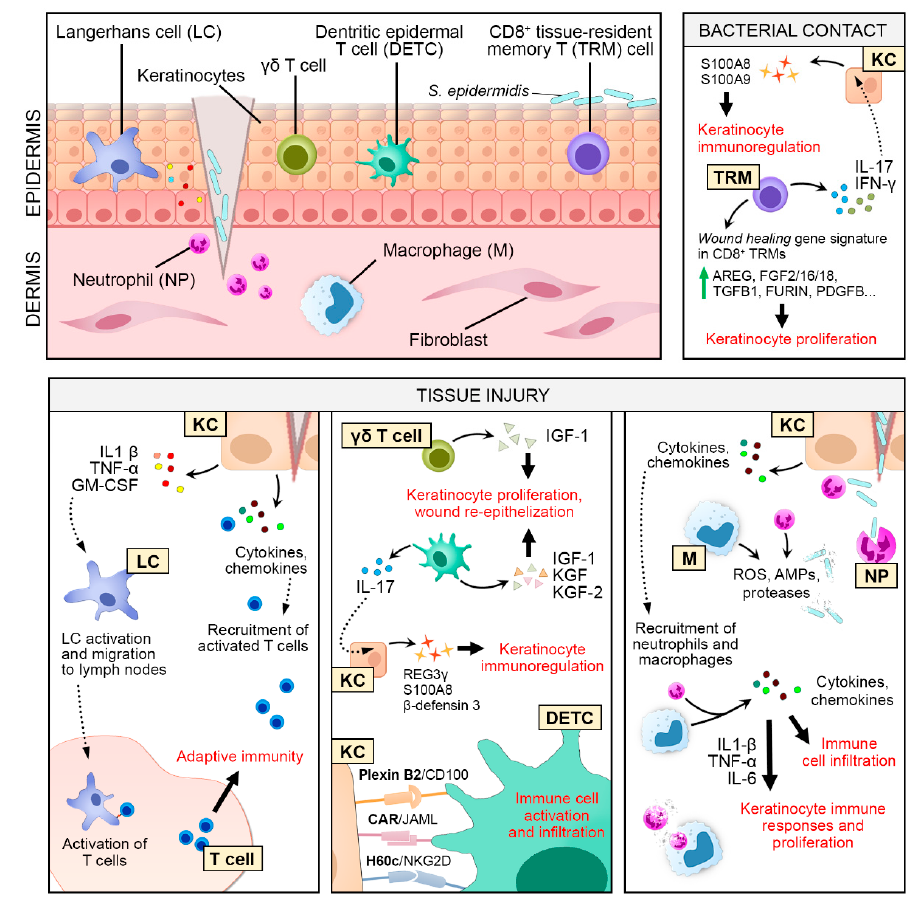
Figure 2. Keratinocyte-immune cell crosstalk in skin wound healing. Keratinocyte (KC)-secreted pro-inflammatory cytokines and chemokines contribute to the recruitment of neutrophils (NP) and macrophages (M) to the site of injury. NP and M remove cellular debris and destroy invading pathogens by phagocytosis and the release of reactive oxygen species (ROS), proteases, and antimicrobial proteins (AMPs). They further amplify the inflammatory response by secreting various pro-inflammatory cytokines and chemokines to recruit more immune cells. Some of these secreted factors, such as interleukin 1 beta (IL-1 β ), tumor necrosis factor (TNF- α ), and interleukin 6 (IL-6) stimulate keratinocyte proliferation and immune responses. After tissue injury, Langerhans cells (LC) react to KC-derived factors and migrate to the draining lymph node to activate T cells, triggering an adaptive immune response. KC-derived cytokines and chemokines serve as a chemoattractant to recruit activated T cells to the wound. Epidermal γδ T cells (human) and dendritic epidermal T cells (DETCs, mouse) respond rapidly to tissue injury and produce growth factors to activate KC proliferation and wound re-epithelization. Vice versa, ligands expressed on the KC cell membrane, i.e., Plexin B2, coxsackievirus and adenovirus receptor (CAR), and H60c are detected by DETCs, triggering immune cell activation and infiltration. DETC-produced interleukin 17 (IL-17) also activates KC to produce antimicrobial peptides (AMPs). Even in the absence of tissue injury, bacterial contact with skin commensal Staphylococcus epidermidis induces CD8 + tissue-resident memory T (TRM) cells to produce IL-17 and Interferon gamma (IFN- γ ), which in turn activate KC to produce AMPs. S. epidermidis -activated TRM cells upregulate the expression of KC mitogens, such as amphiregulin (AREG), fibroblast growth factor 2 (FGF2), and transforming growth factor beta 1 (TGFB1), to promote keratinocyte proliferation. In the later phase of wound healing, the engulfment of apoptotic NP by M is essential for M’s conversion into an anti-inflammatory phenotype and the production of several key factors for wound healing, including TGFB1, vascular endothelial growth factor (VEGF), and platelet-derived growth factor